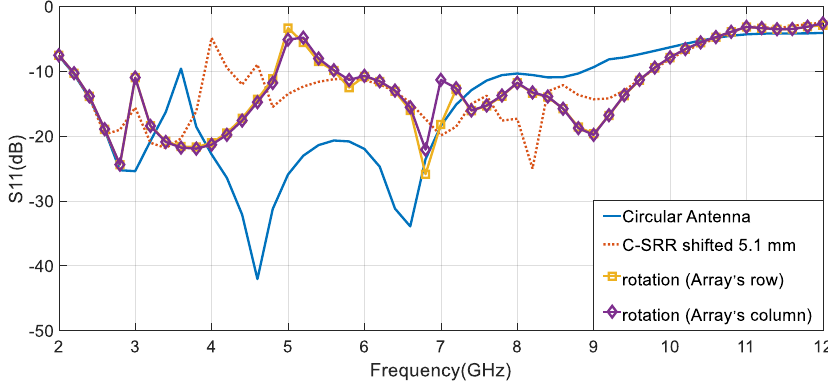
Figure 29. S 11 for the antenna of shifted C-SRR and inner ring rotation horizontally and vertically.